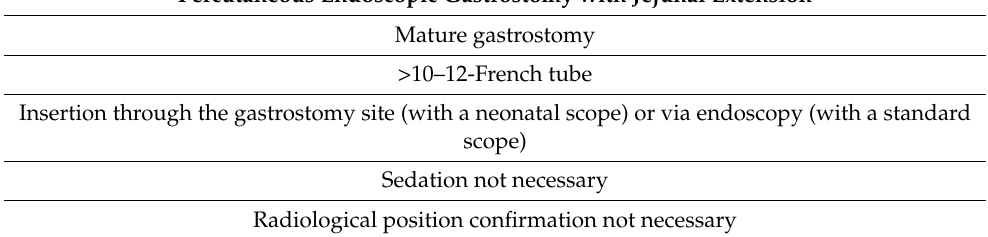
Table 1. Step-by-step protocol of the placement of a percutaneous endoscopic gastrostomy with jejunal